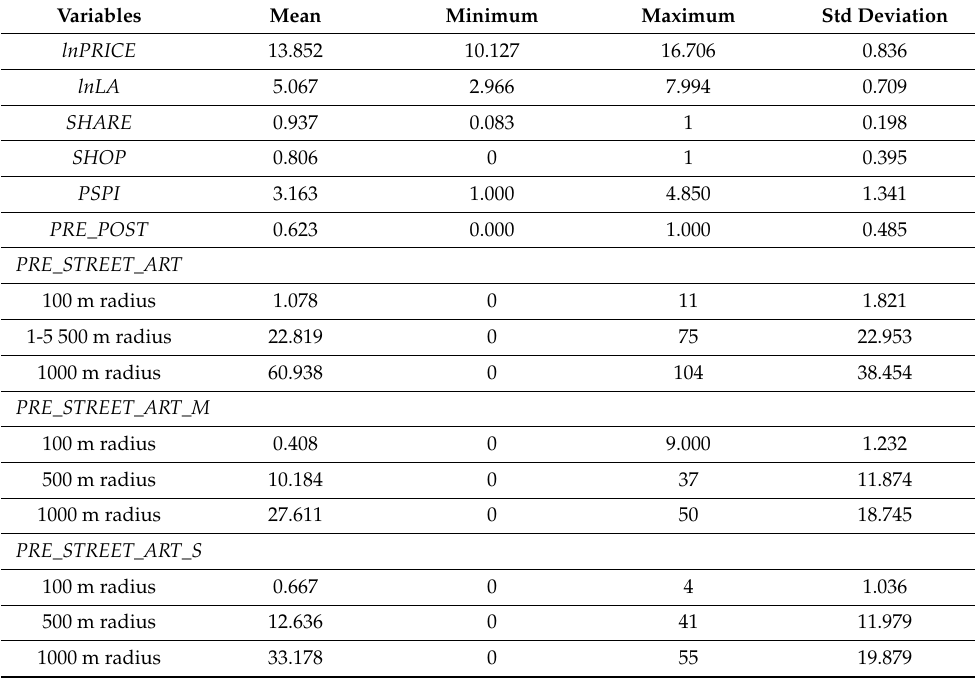
Table 3. Descriptive Statistics of